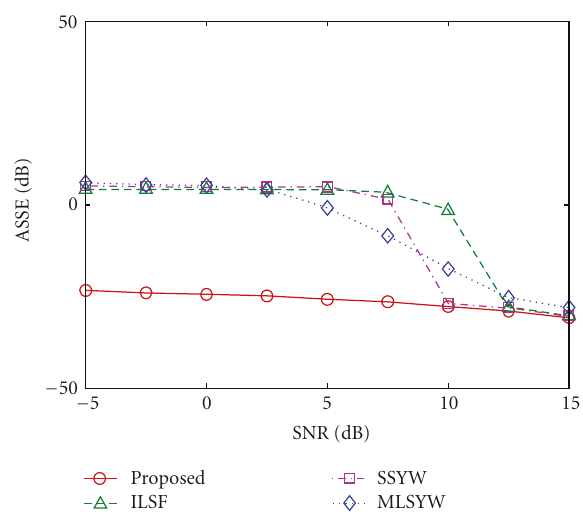
Figure 1: E ff ect of noise level on the ASSE for a white noise-excited